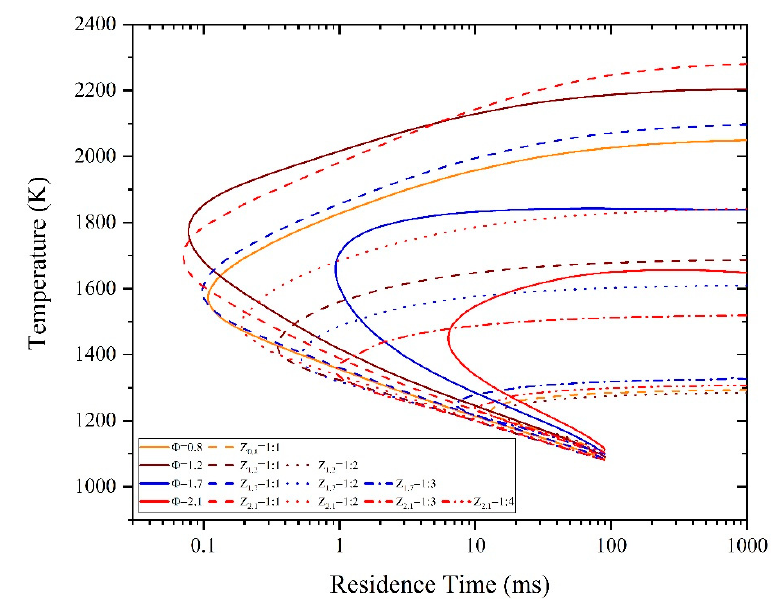
Figure 13. Comprehensive comparison of C-curves of air–light hydrocarbon mixing gas at different mixing degrees and n -pentane at equivalence ratios of 0.8, 1.2, 1.7, and 2.1, respectively.